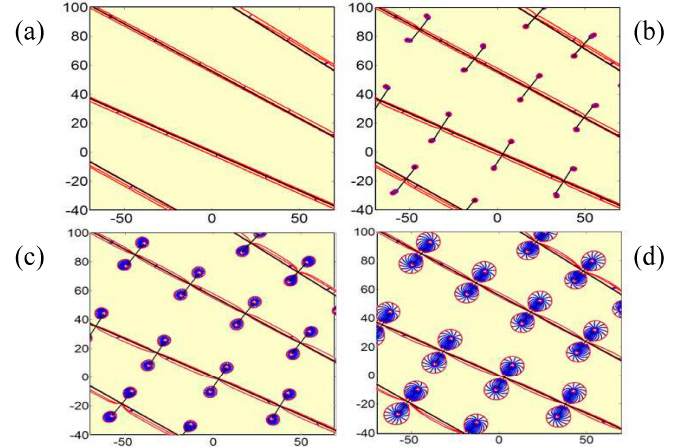
Figure 12. ( a – d ) Drained region after 1 month of production (red contours). ( a ) micro-cracks absent, ( b , c ) micro-cracks with increasing hydraulic conductivity as in Figure 11a–c.